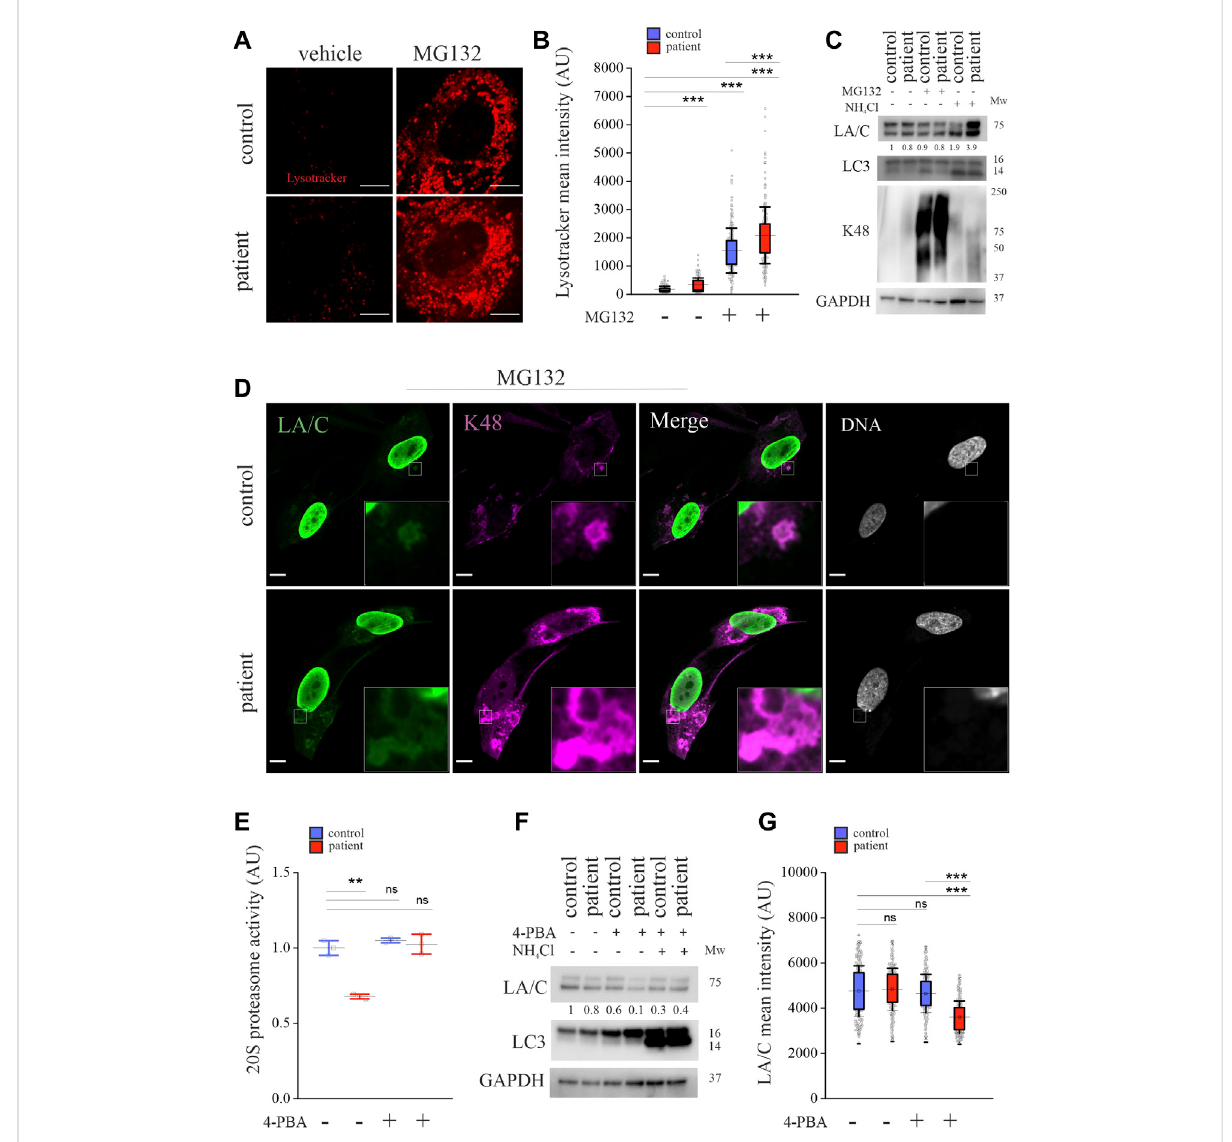
FIGURE 4 Crosstalk between autophagy and UPS is impaired in LMNA mutant patient cells. (A) LysoTracker Red DND-99 staining from untreated and MG132-treatedcontrolandpatientcells. (B) Calculatedmean fl uorescenceintensityvaluesshowmoreLysoTrackerpositivelysosomesinthepatient cellsandtheirnumberisfurtherincreasedafter24-htreatmentwith1 µMMG132. (C) Westernblotanalysisfromcontrolandpatientcellstreatedwith 1 µMMG132or20 mMNH 4 Clfor24 h.ProteinlevelsoflaminsAandC(LA/C)werenormalizedtoGAPDH,whichwasusedasaloadingcontrol. All the proteins were detected on the same membrane. (D) Confocal microscopy images from control and patient cells treated with MG132 and stainedforlaminsAandCandK48-ubiquitin.Insetsshowcytosolicstructuresthatco-stainwithlaminsAandCandK48antibodies.Scalebar10 µm. (E) Chymotrypsin-likeactivityasmeasuredincontrolandpatientcellstreatedwith5 mM4-PBAfor24 h(N=3individualexperiments)** p < 0.01. (F) Western blot analysis of control and patient cells treated with or without 5 mM 4-PBA. Autophagy was inhibited with 20 mM NH 4 Cl and GAPDH was used as a loading control. (G) Calculated mean fl uorescence intensity values (AU) from control and patient fi broblasts treated with or without 5 mM 4-PBA for 24 hand stained forlaminsA andC (N=300).The whiskers show meanvalues ±s.d andboxplotsshow the75th and25th percentiles, * p < 0.05, *** p <